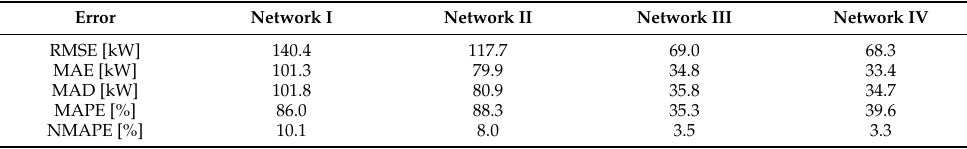
Table 10. Summary of power forecast error for wind power plant FW4.